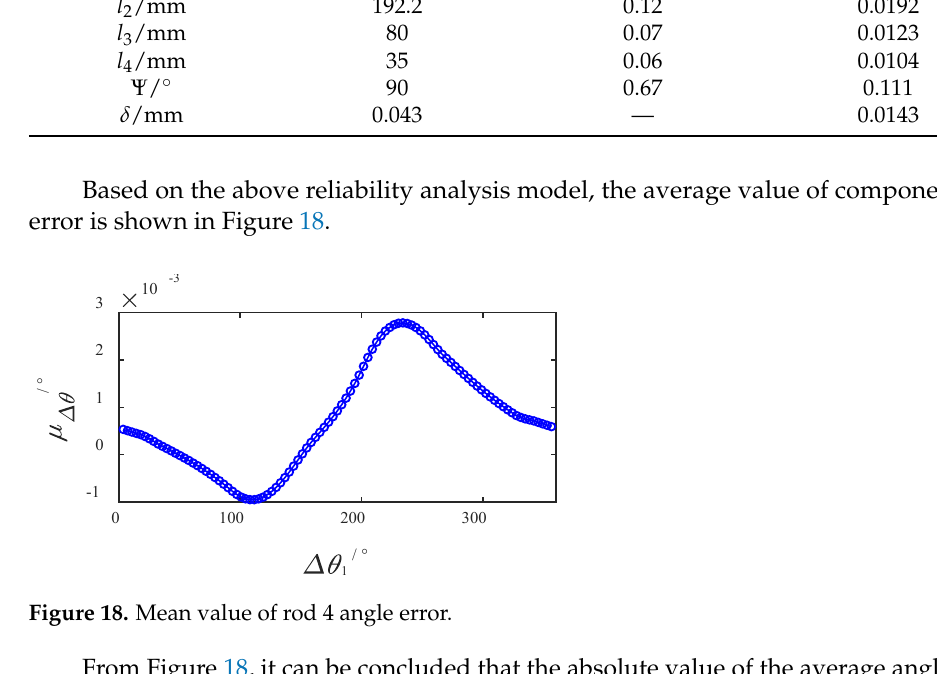
11.48 Table 3. Comparison of connecting rod parameters. Status